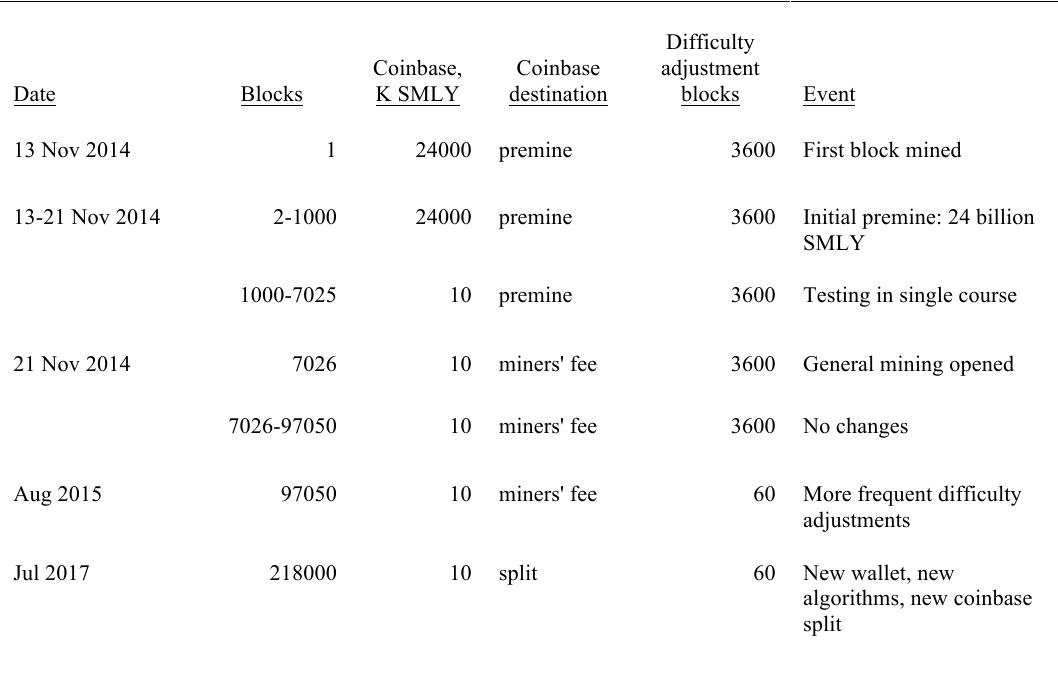
Table 1. Timeline of SMLY development and changes, indicating testing phase, premine blocks, difficulty adjustment changes, all changes to mining algorithms (from Scrypt-only to adding SHA256, Groestl, Qubit, Skein) and the coinbase split into miners' fee, dividends and